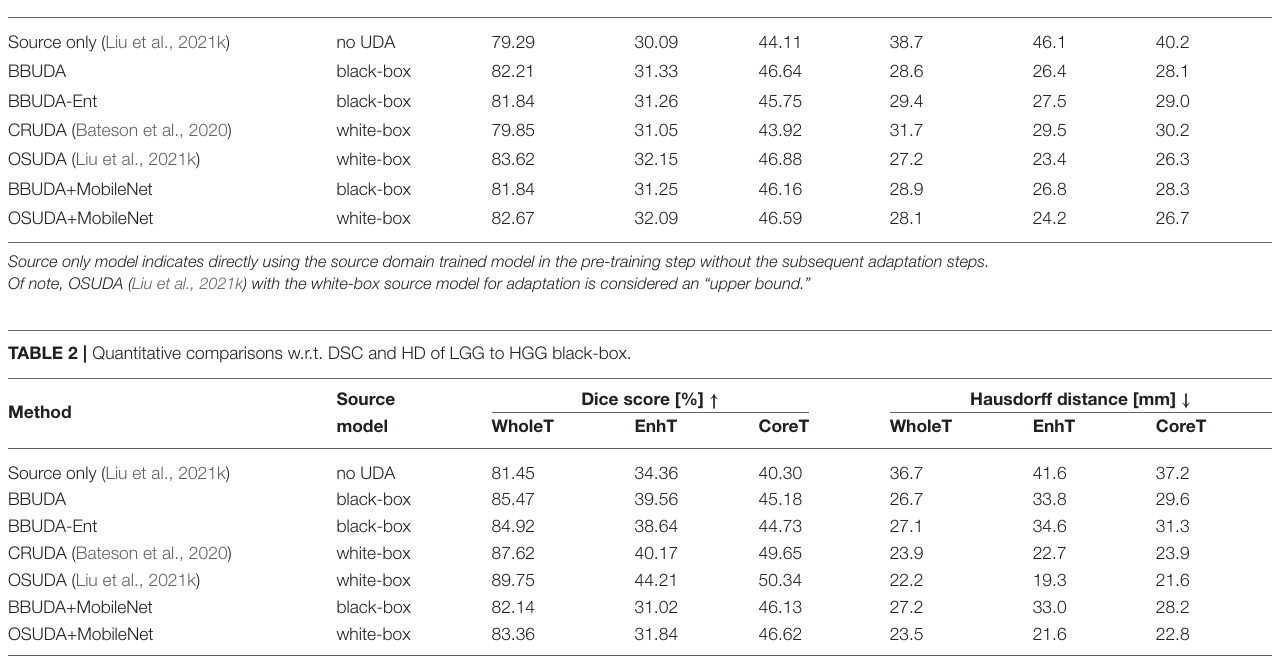
Figure 2 . As a preprocessing step, all of the imaging modalities for each subject were registered with each other, including T1- weighted (T1), T1-contrast enhanced (T1ce), T2-weighted (T2), and T2 Fluid Attenuated Inversion Recovery (FLAIR)